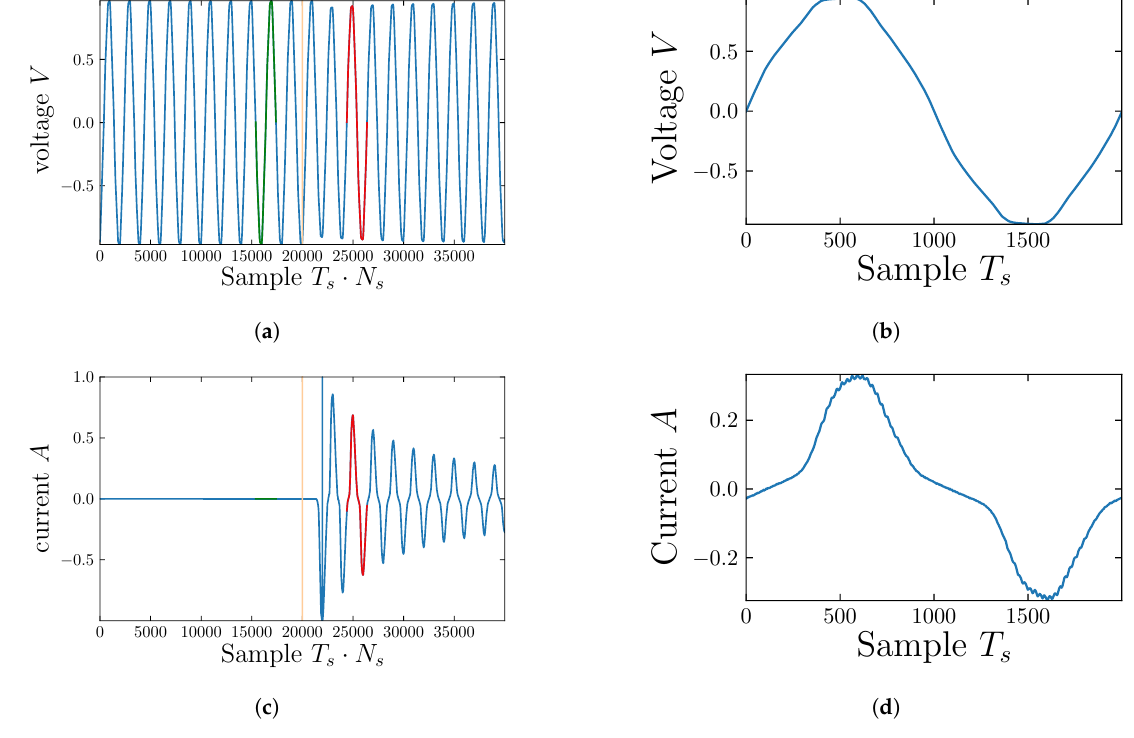
Figure 2. Extraction of an activation signal from current and voltage measurements. The green color is the steady-state signal before the event where the steady-state signal after the event is shown in red: ( a ) Voltage waveforms before and after an event; ( b ) Activation voltage; ( c ) Current waveforms before and after events; ( d ) Activation